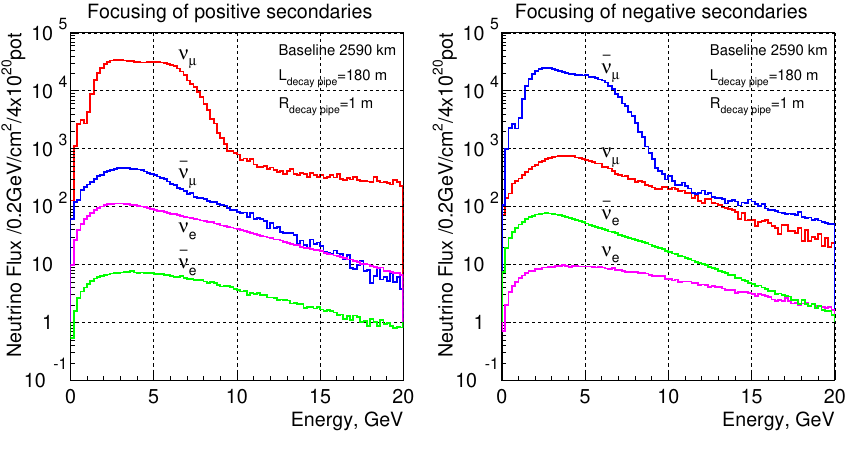
Figure 1. Simulated spectra of the P2O neutrino beam at the ORCA location in neutrino (left panel) and antineutrino (right panel) modes. The absolute normalization is given for 4 (POT), which corresponds to 1 yr of operation at the beam power of 450